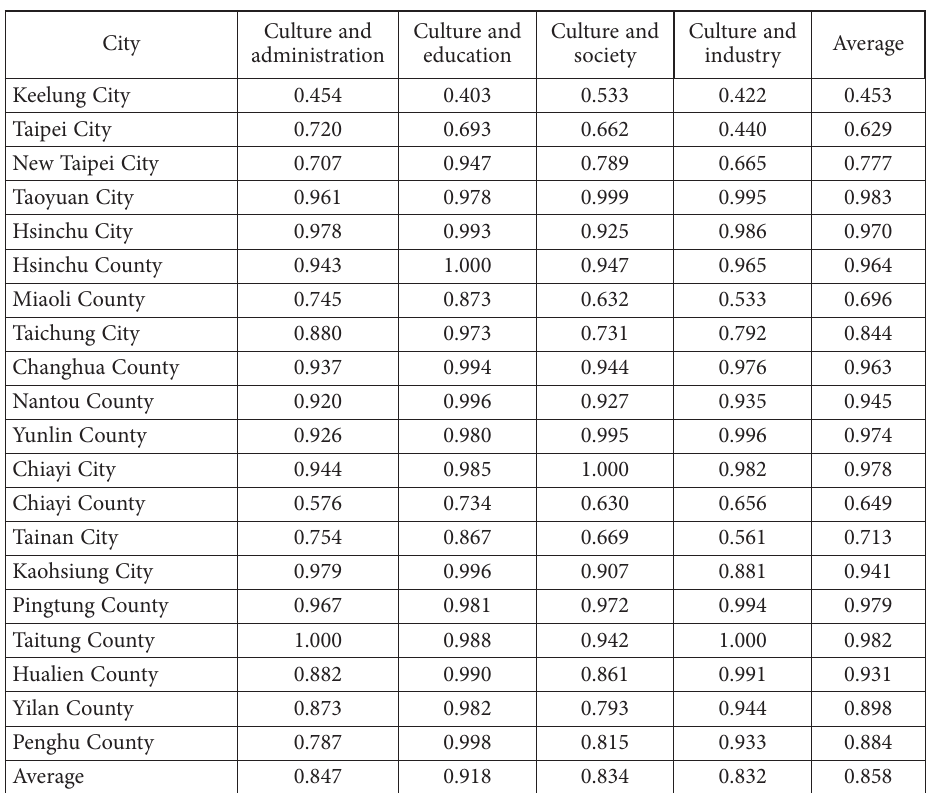
Table 3. Grey relational